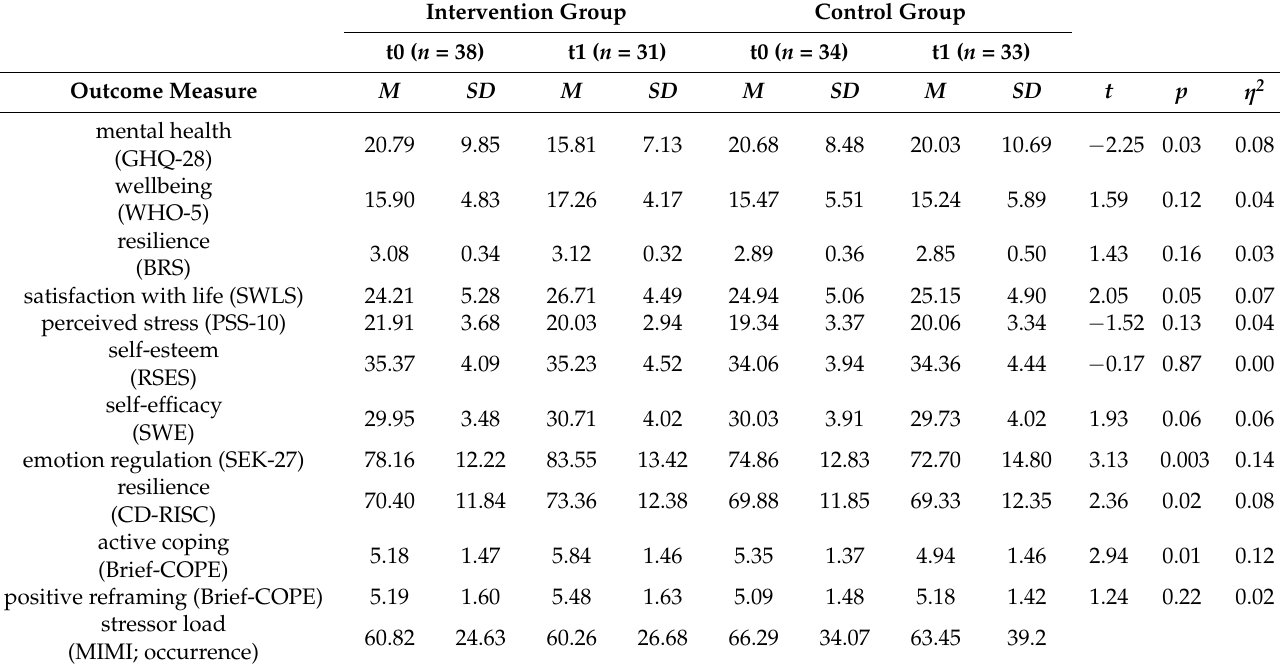
Table 2. Descriptive statistics for pre-post data and analysis of group differences using ANCOVA for outcomes at t1 adjusted for the outcome at